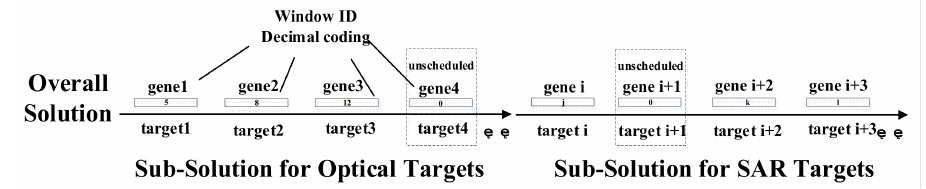
Figure 2. Solution coding